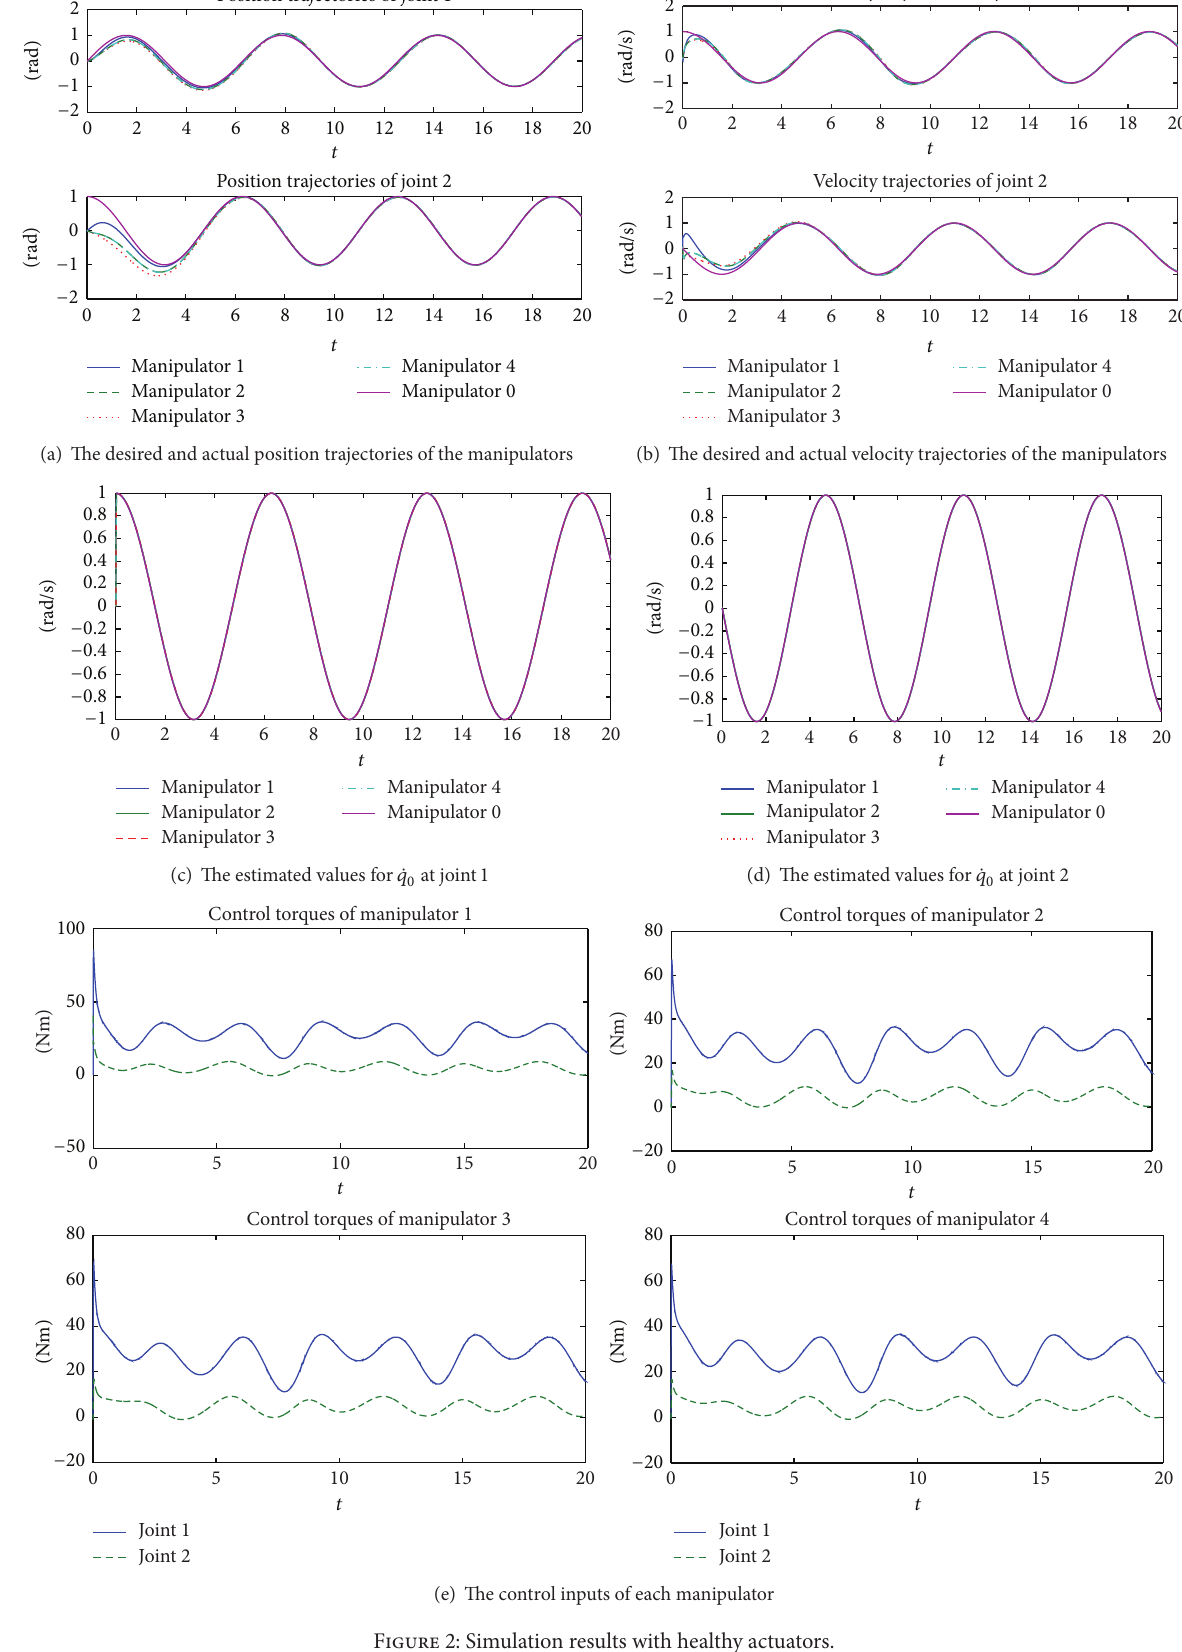
Figure 2: Simulation results with healthy